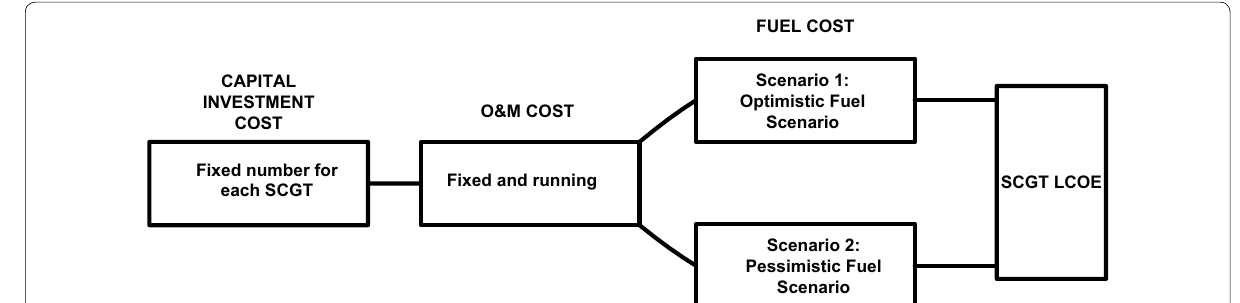
Fig. 6 Fuel cost scenarios applied to conduct LCOE value of each traditional generation